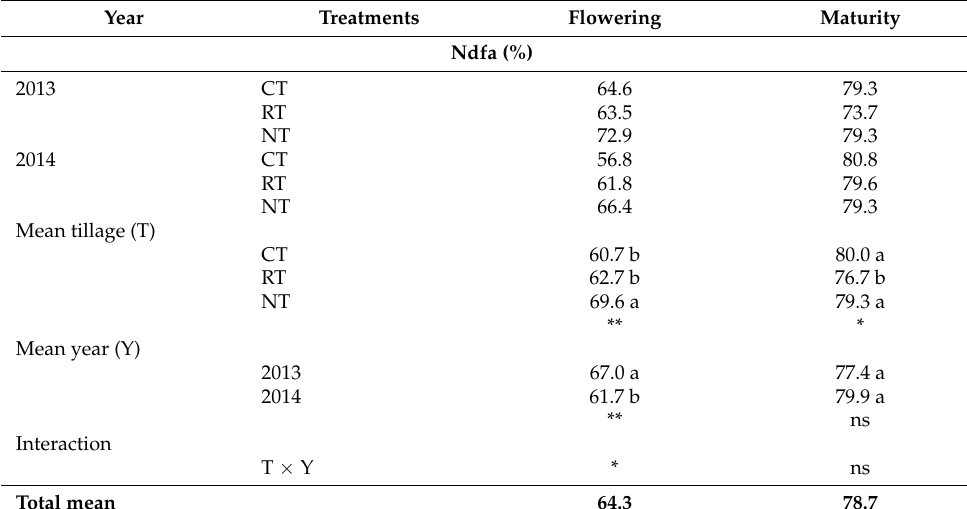
Table 5. Atmospheric N 2 fixation by faba bean (%Ndfa) at flowering and maturity with respect to tillage system and growth